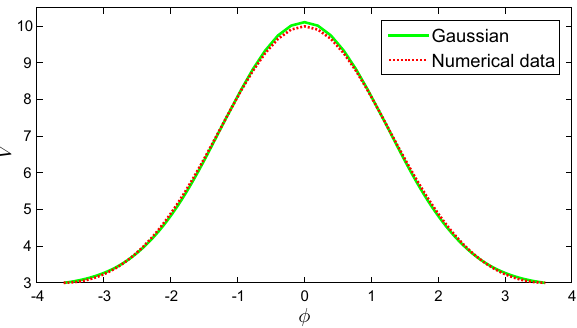
Fig. 7 Plot of the numerical data for V (φ) and the Gaussian fit defined by Eq. (36), for the values c = 0 . 5 and s = 1